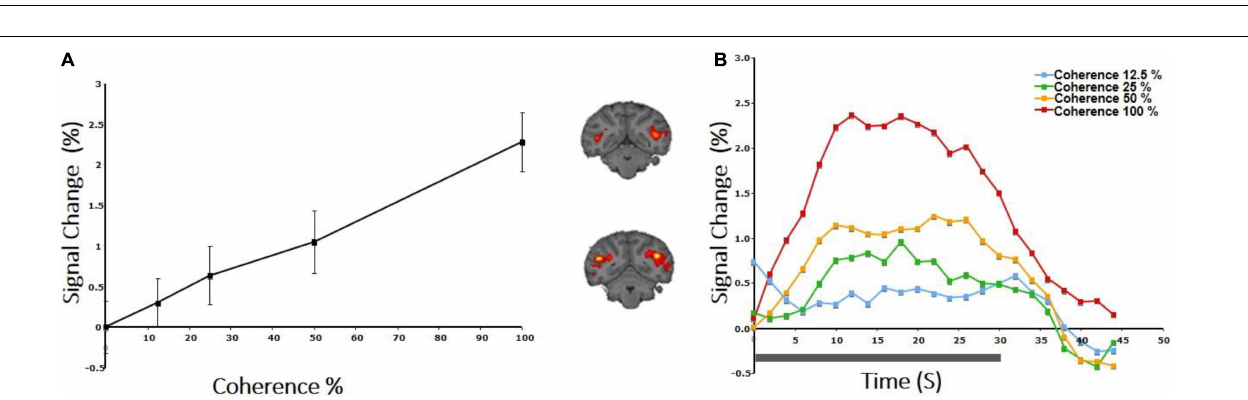
areas V1, V2, V3, V3A, and FST were, in general, less sensitive to coherence, displaying similar features as the corresponding areas in the